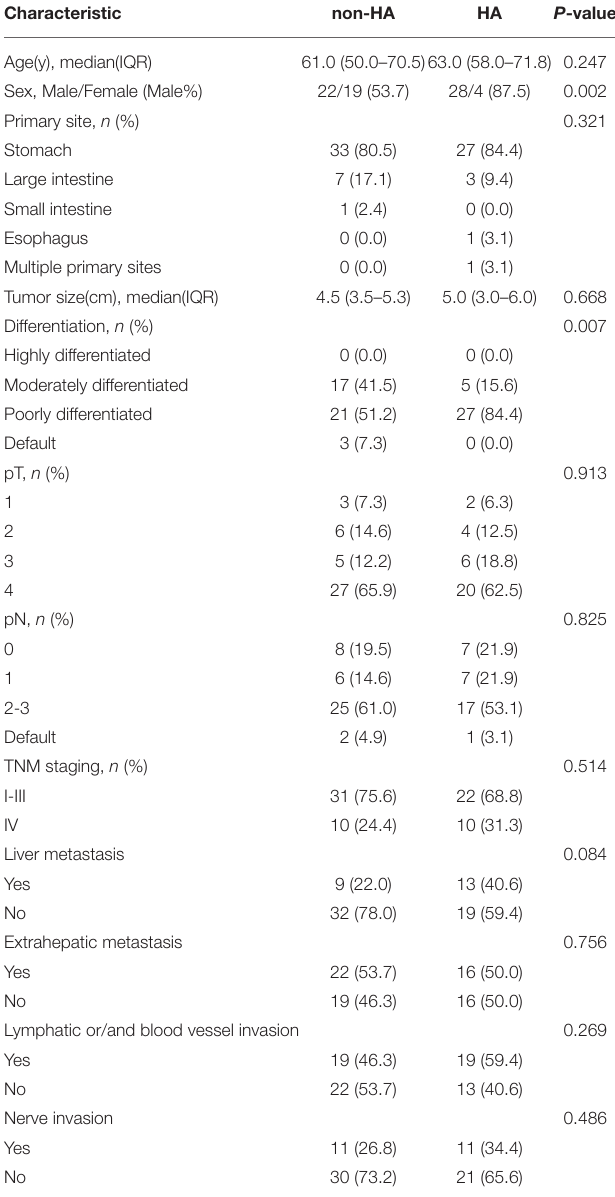
TABLE 3 | Comparison of clinical baseline characteristics between APA-GI patients with HA and non-HA. Characteristic